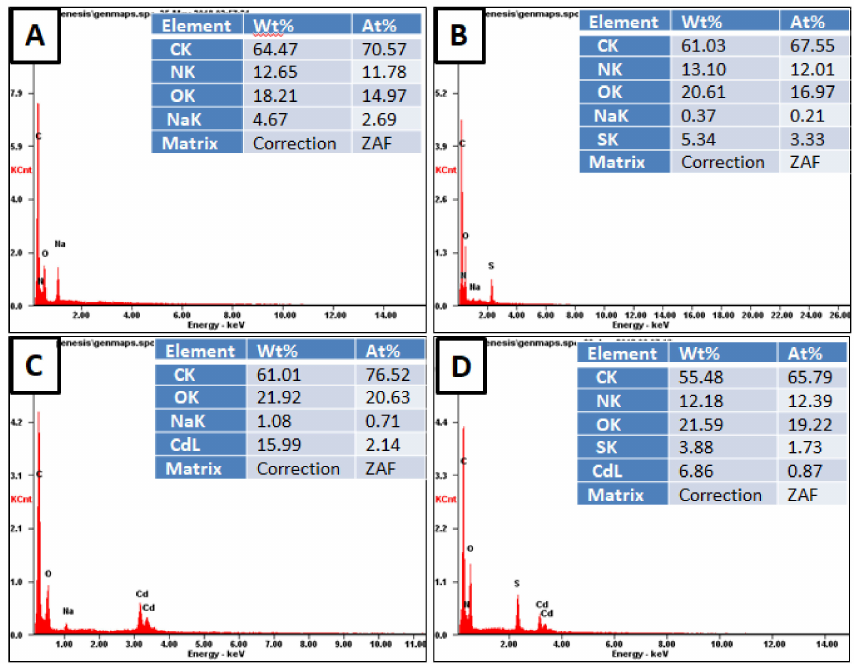
Figure 4. Elemental composition of the cryogels before and after interaction with metal ions according to spot EDX analysis ( A ) p(MAAc)-DMAAm-AA, ( B ) p(AMPS)-DMAAm-AA, ( C ) p(MAAc)-DMAAm-AA-Cd and ( D )